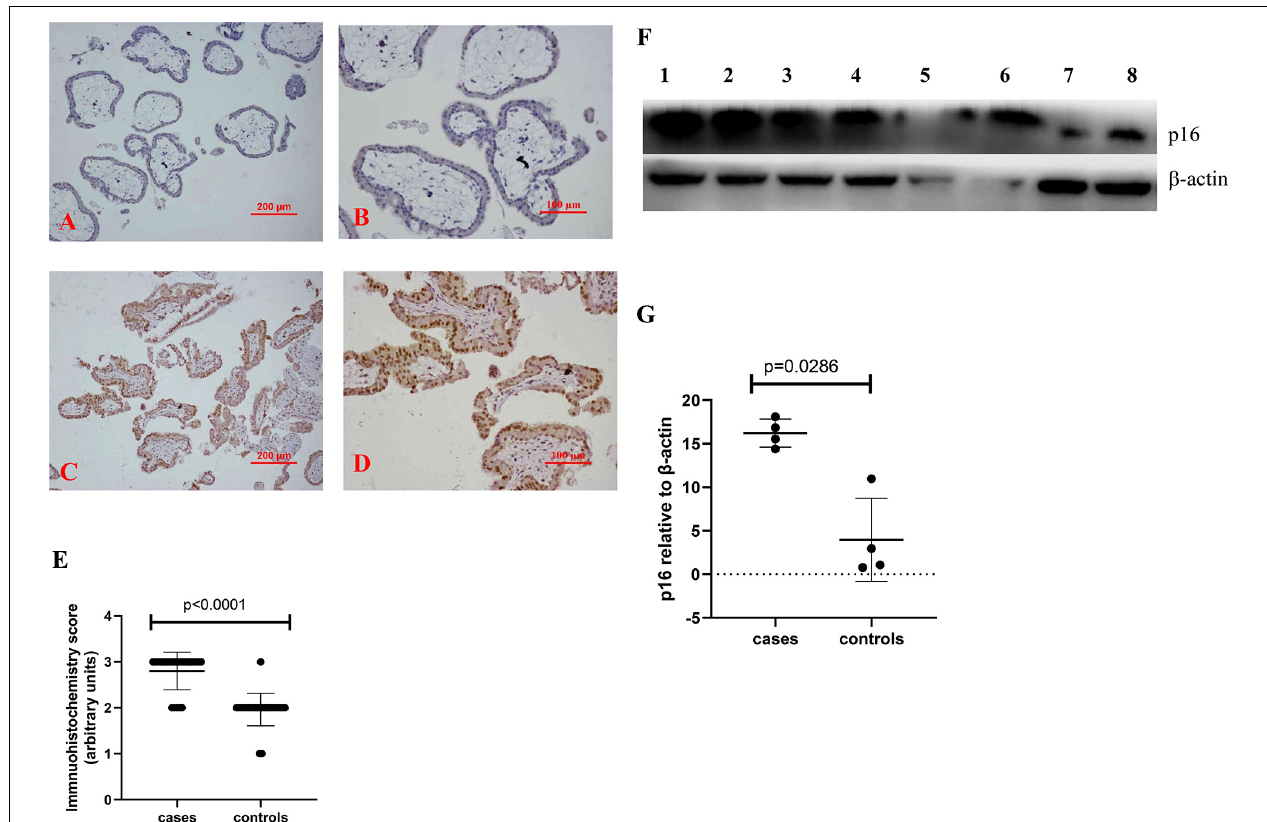
FIGURE 1 | Representative immunohistochemical staining showing that the levels of p16 were increased in missed miscarriage placentas [ (C) low magnification, D: high magnification] compared to healthy first-trimester placentas [ (A) low magnification, B high magnification]. Semiquantitative analysis of the immunohistochemistry images showing a significantly increased expression of p16 in placentas from missed miscarriage (E) . Representative Western blot (F) demonstrating that the levels of p16 were significantly increased in missed miscarriage placentas (lanes 1–4) compared to controls (lanes 5–8), measured by a semiquantitative analysis (G) .